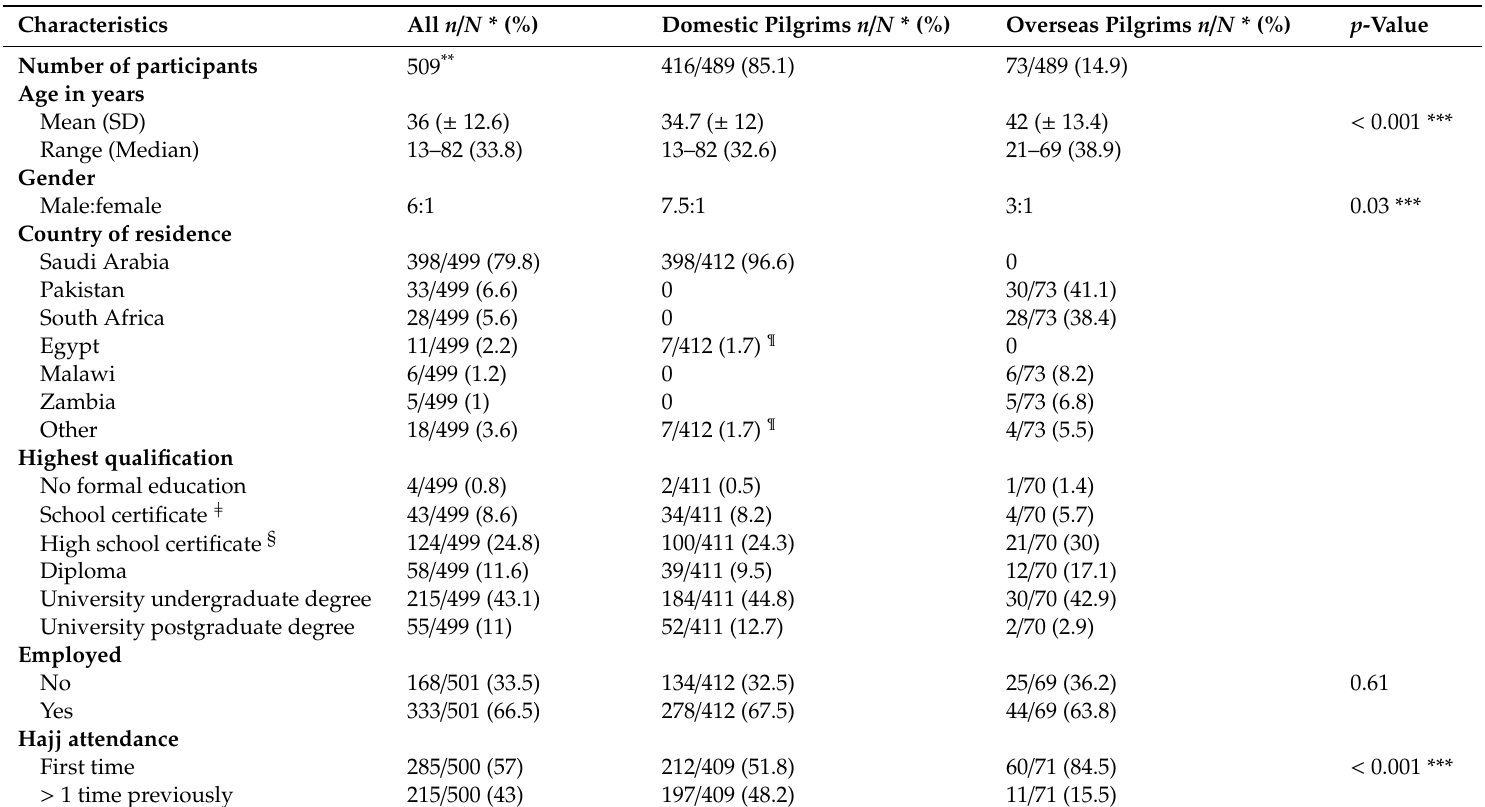
Table 2. Demographic characteristics of the domestic and overseas